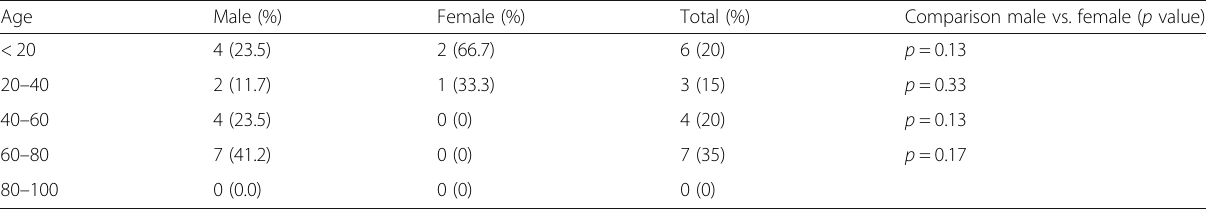
There is no evidence to demonstrate any association between age and gender with respect to epilepsy in the population studied. In addition, the proportion is relatively high in the <20years, but there is no evidence to show any significant differences between gender. Fisher ’ s